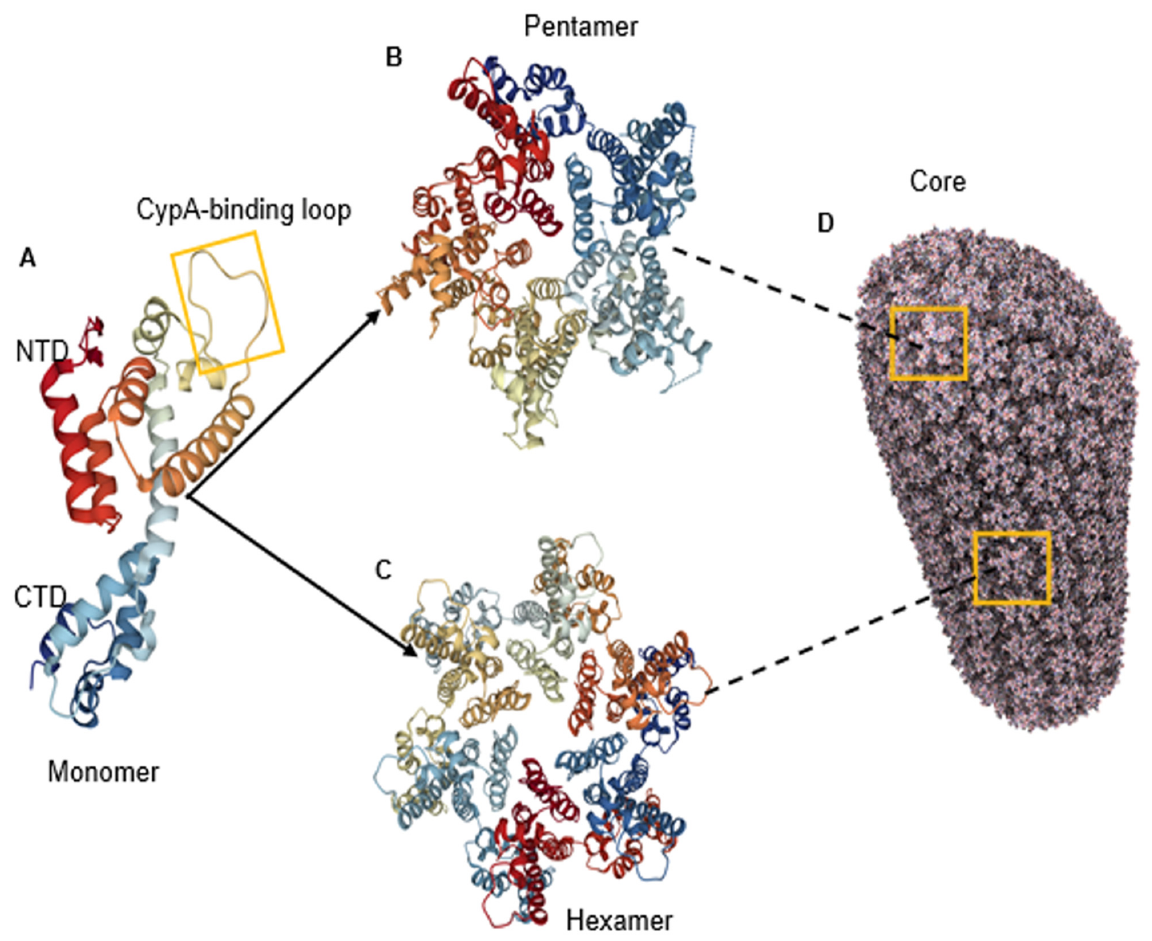
Figure 1. Structure of HIV-1 capsid. ( A ) The structure of the CA monomer showing the N-terminal domain (NTD), the C-terminal domain and the CypA-binding loop (highlighted) (PDB 4XFY) [20]. ( B ) The structure of pentameric HIV-1 CA (PDB 3P05) [21]. ( C ) The structure of hexameric HIV-1 CA (PDB 4XFY) [20]. ( D ) The hexameric and pentameric subunits assemble into a fullerene conical capsid core (PDB 3J3Y). In this model, the core is composed of 186 hexamers and 12 pentamers